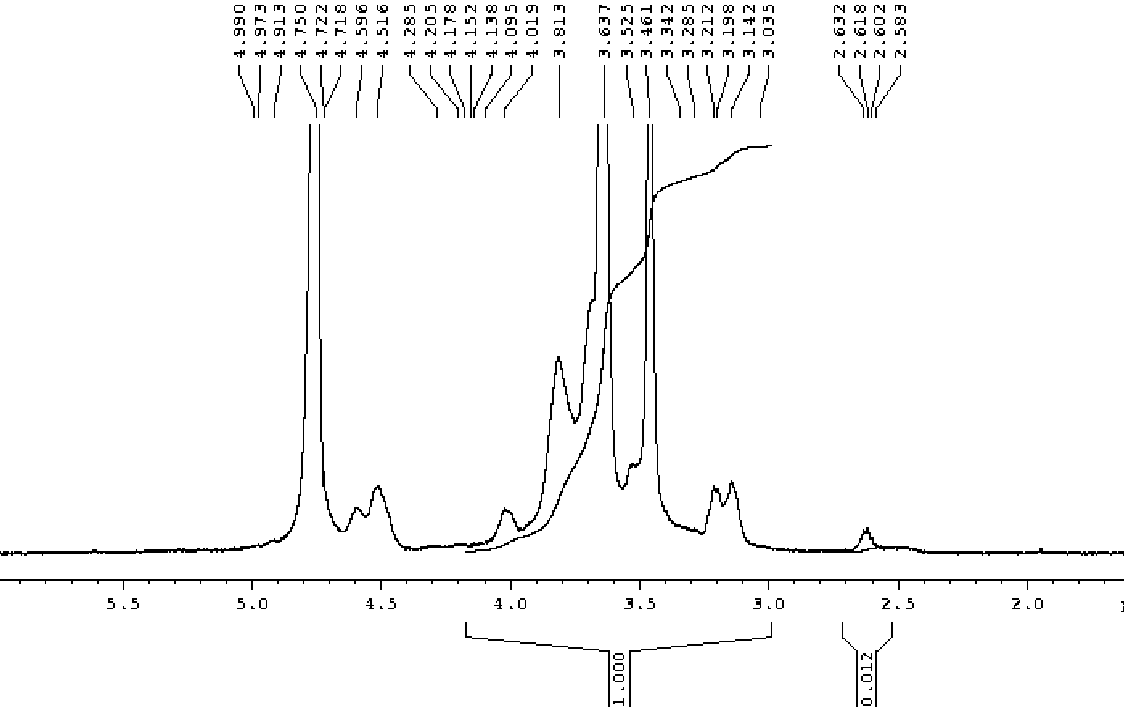
Figure 10. 1 H NMR spectrum of  -alanine grafted on ME 50 oxidized methylcellulose in D O solution at 30 2